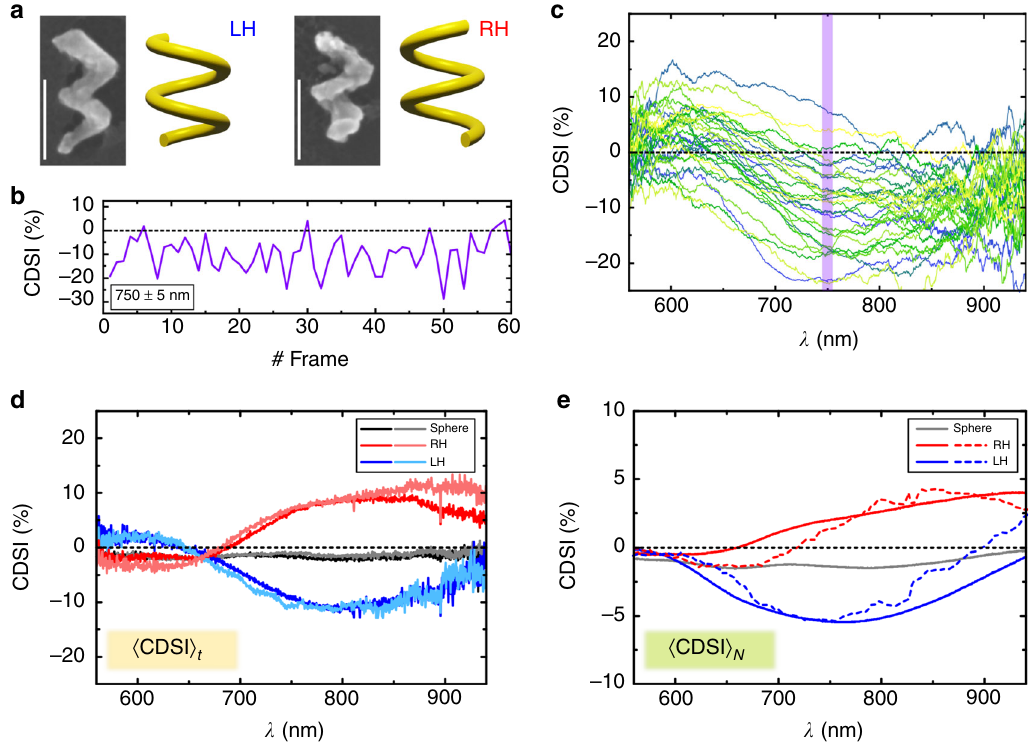
Fig. 2 Time-resolved chiroptical spectroscopy of freely diffusing single nanohelices. a SEM and schematics of Au nanohelices (scale bar 100 nm). b Frame-wise CDSI at λ = 750 ± 5 nm for a single left-handed nanohelix that is undergoing Brownian motion. c Full CDSI spectra for momentarily aligned orientations in 3D space corresponding to the fi rst 30 frames shown in ( b ). The purple vertical line indicates the spectral region shown as a time-trace in ( b ). d 〈 C DSI 〉 t ( t = 400 frames) for freely diffusing single Au nanohelices and nanospheres. For each shape two measurements from different particles are shown in different shades of grey, red and blue. e 〈 CDSI 〉 N of the same Au helices and spheres presented in d measured in the setup according to Fig. 1b (solid lines) and by utilizing a classical chiroptical measurement with a cuvette (dashed lines, data scaled). The latter detects under a different scattering angle (see Supplementary Fig. 3 and Note